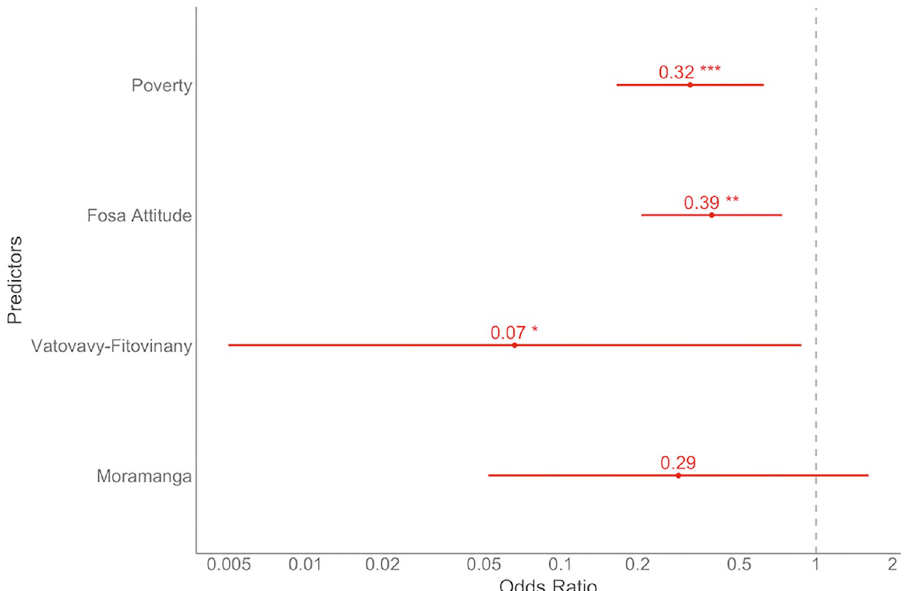
Fig 6. Forest plot of the three significant predictors of retaliatory killing, attitude, poverty and region (reference level is Menabe) (with 95% confidence intervals). The level of significance is denoted by ��� p < 0.01, �� p < 0.05 and ��� p <